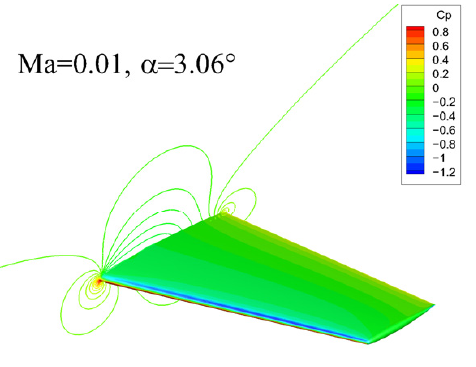
Figure 18. Contours of pressure coefficient (𝑀𝑎 = 0.01, 𝛼 = 3.06°) .